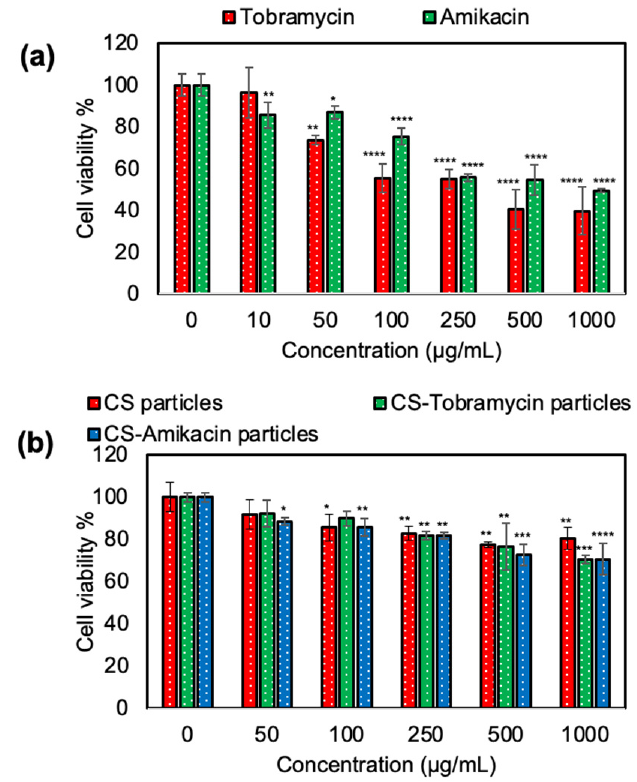
Figure 6. ( a ) Hemolysis and ( b ) blood clotting index of CS particles, CS-Tobramycin particles and CS-Amikacin particles crosslinked at 50% mole ratios. [*, **, ***, **** represent p < values of 0.05, 0.01, 0.001, and 0.0001, respectively].